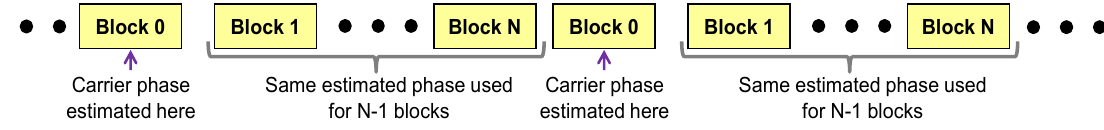
Figure 3. Block processing chart for the carrier phase estimation algorithm.